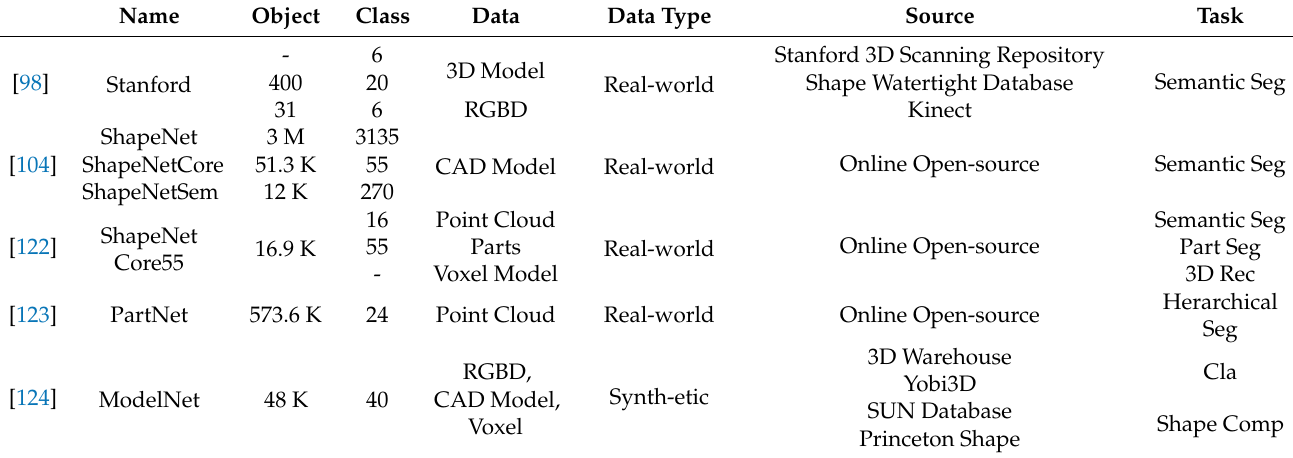
Table 1. Comparative summary of existing indoor object-level dataset (Seg: segmentation; Rec: recognition; Cla: classifica- tion; Comp: